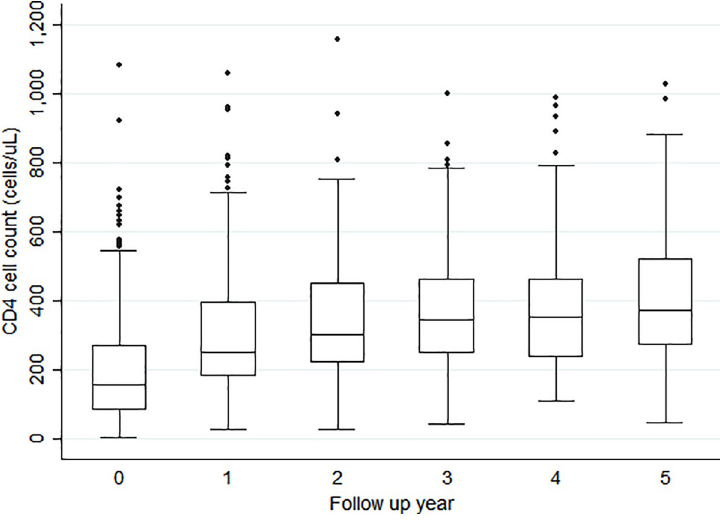
Fig 2. CD4 T-cell count distribution across follow-up time (3 outliers, 2 Year 0 and 1 Year 1, with CD4 count > 1250 cells/uL omitted from graph) (p < 0.01).